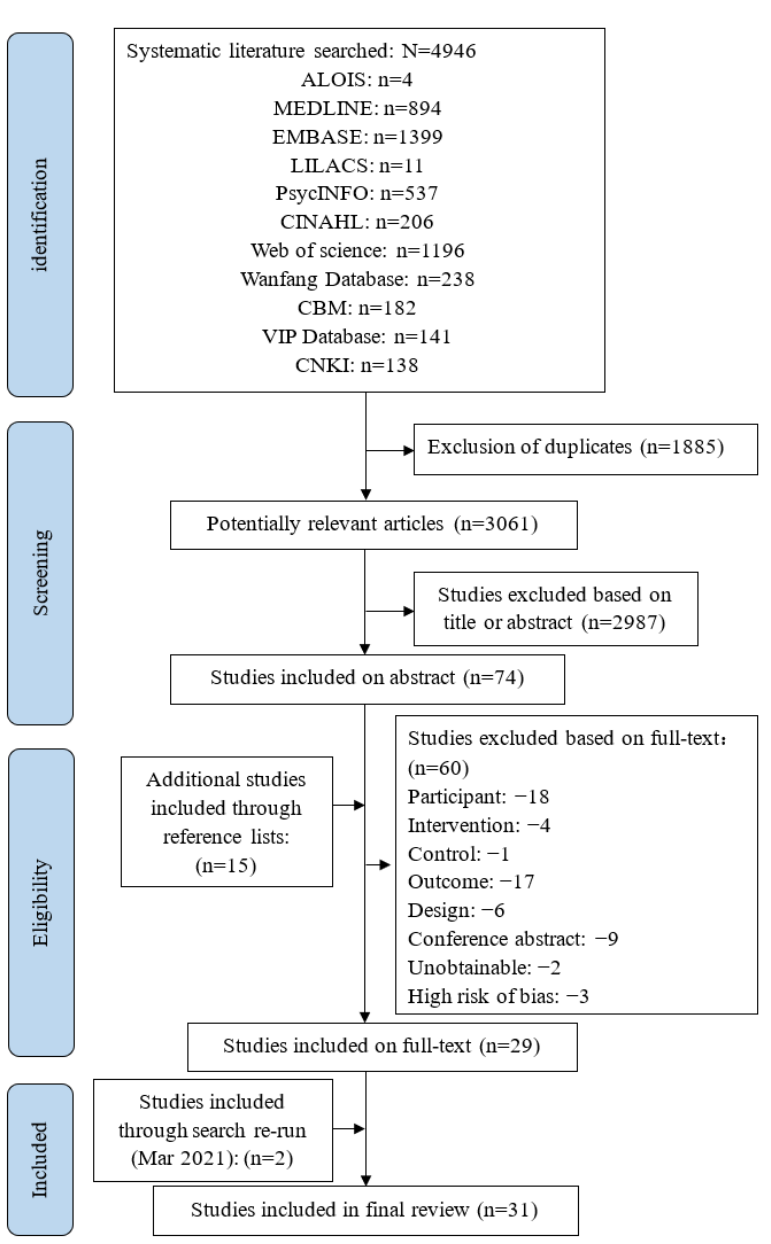
Figure 1. Flowchart for studies selection.